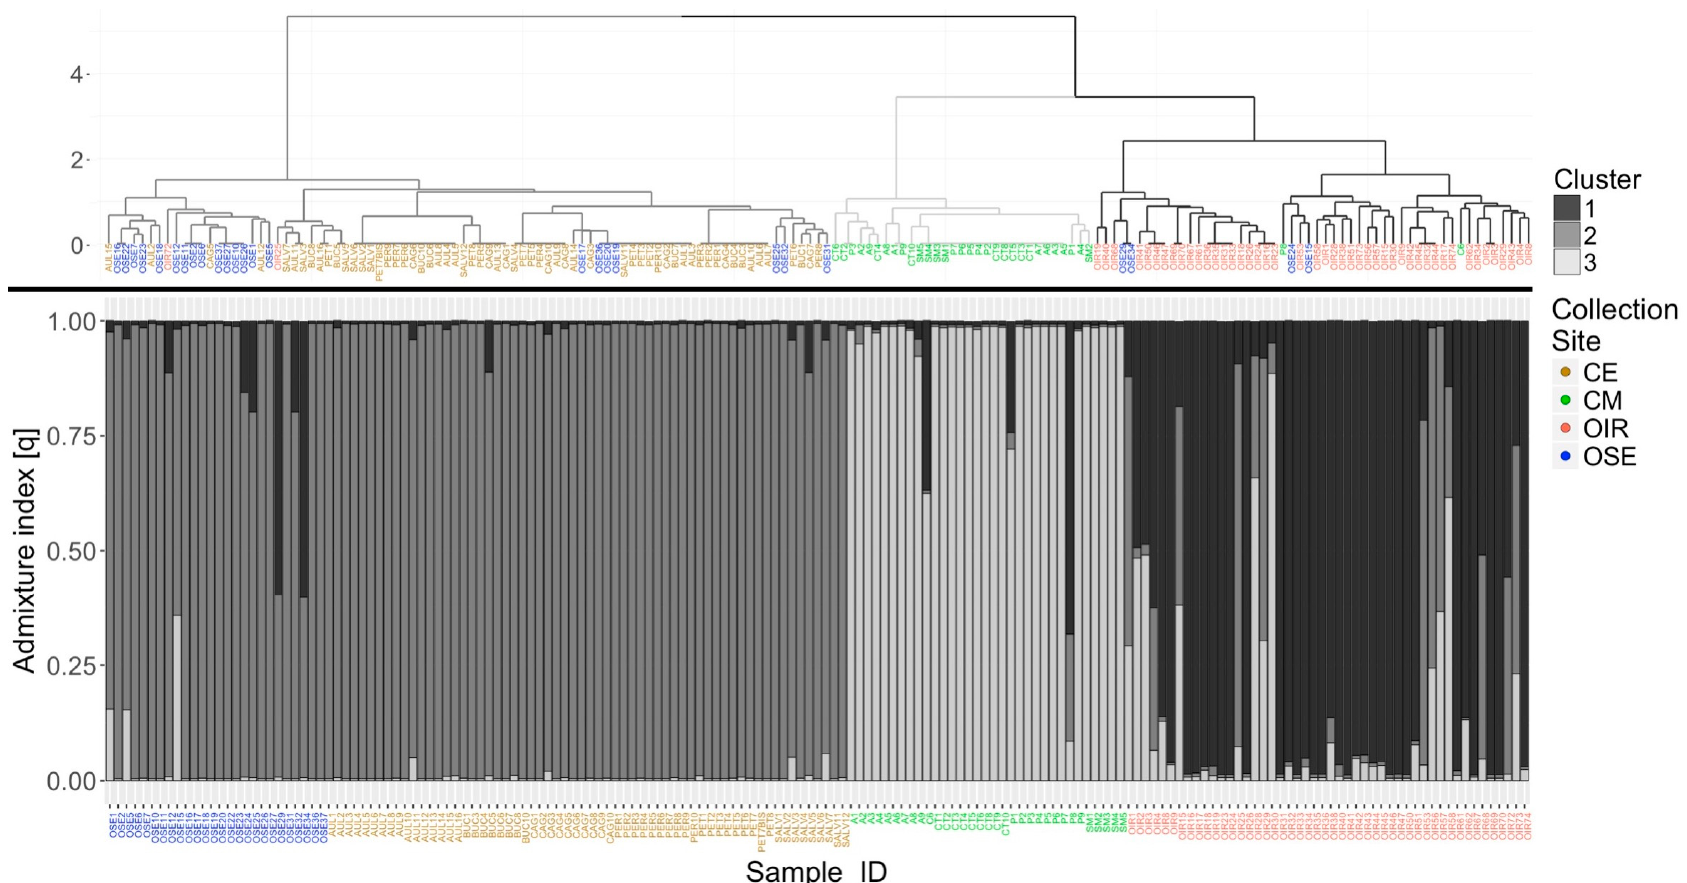
Figure 2. Comparison between the dendrogram calculated with the Ward method on the genetic distance among samples, based on the similarity index of Dice–Sørensen (above), and the clustering obtained through the population analysis conducted with the STRUCTURE software [CE: Cilento hinterland (brown color), CM: Cilento coastal area (green color), OIR: olives of the Irpinia area (red color), OSE: olives along the Sele river (blue color)].